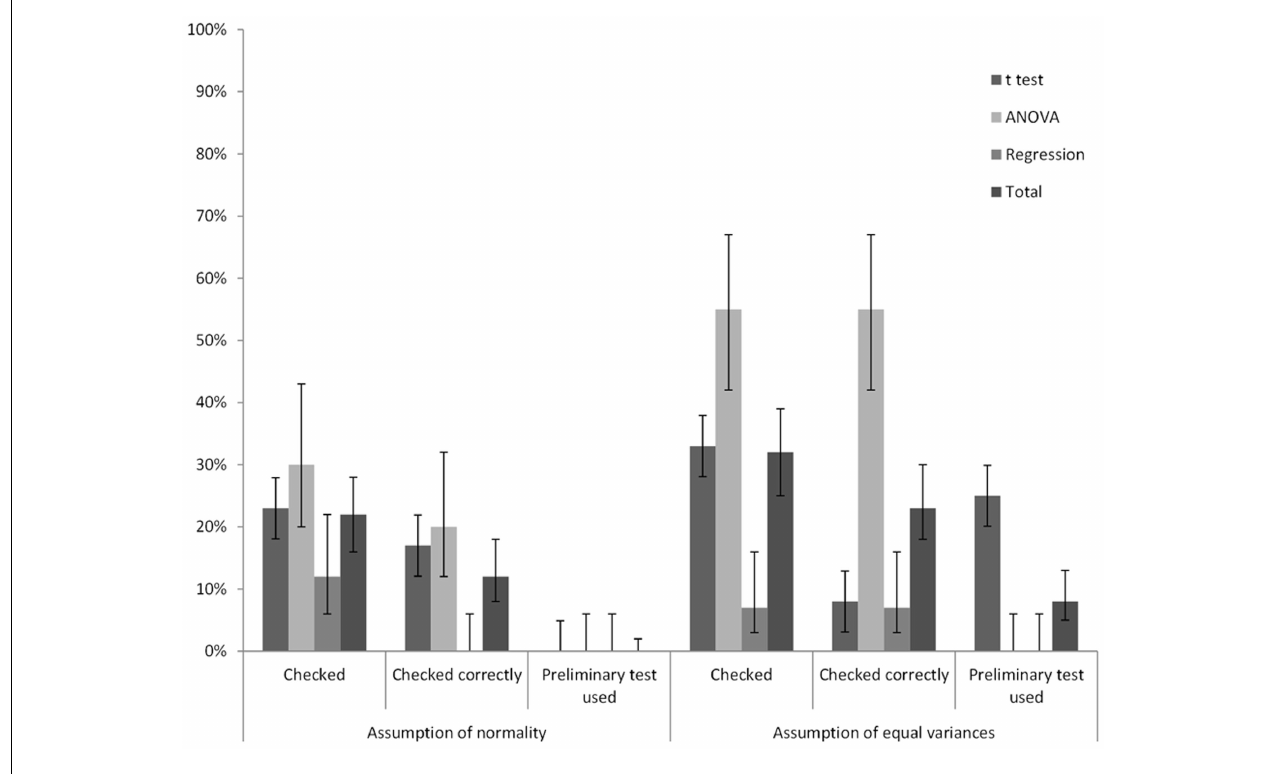
FIGURE 2 |The frequency of whether two assumptions were checked at all, whether they were checked correctly, and whether a preliminary test